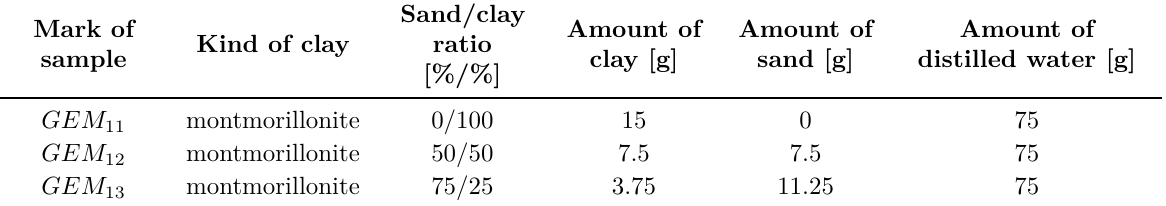
Table 1. Composition of earth samples for the measurement where stirring time 1 minute is used for each 1 ml of MB solution in earth samples.